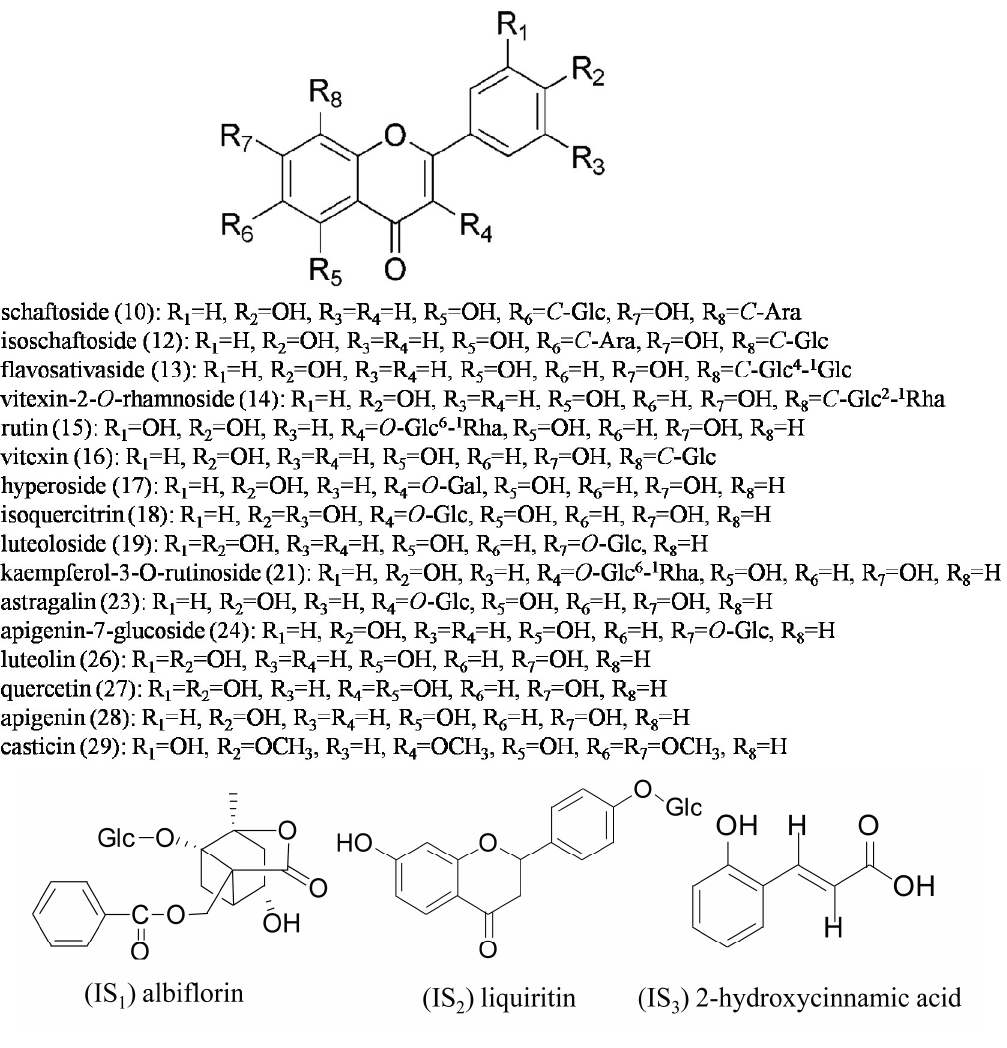
Figure 4. Chemical structures of the 29 investigated compounds and three internal